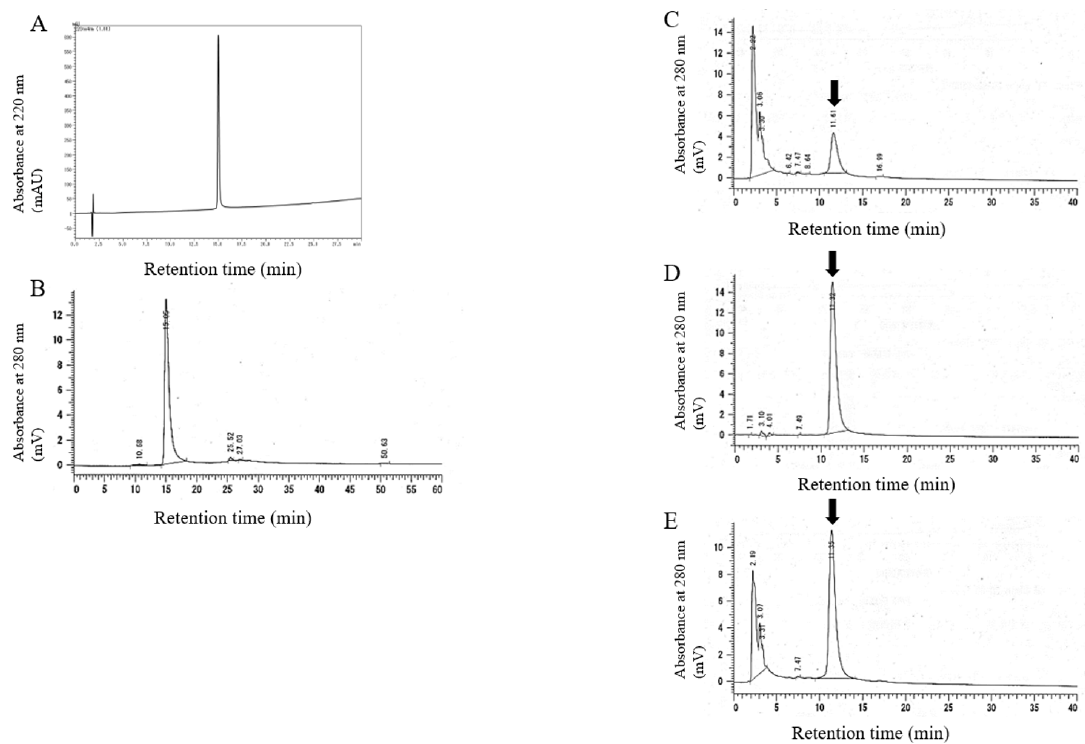
Figure 1. Analysis of 20kPEG-AM. Purity was estimated by RP-HPLC ( A ). Analysis of molecular size in a solution using gel filtration chromatography ( B ). Elution profiles from ion-exchange chromatography (( C ), CNBr-digested 20kPEG-AM; ( D ), AM(6–52); ( E ), coinjection of CNBr-digested 20kPEG-AM and